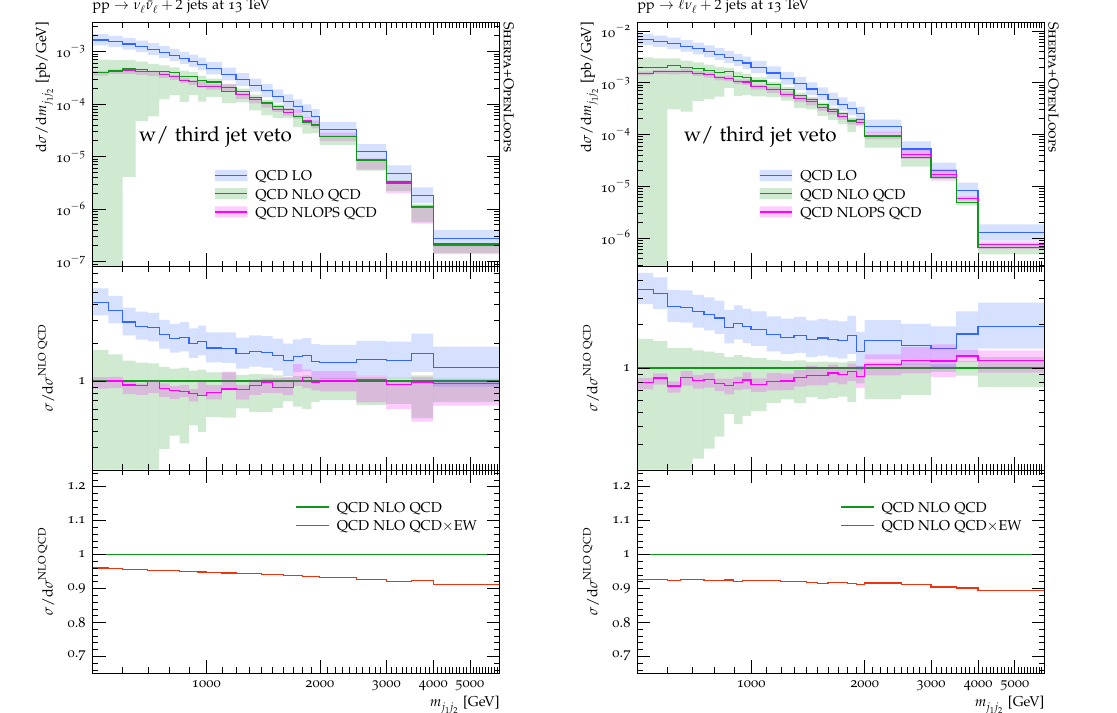
Figure 5. Distribution in the invariant mass of the two hardest jets, m j Z ( ν ‘ ¯ ν ‘ ) + 2 jets (left) and QCD pp → W ± ( ‘ ± ν ‘ ) + 2 jets (right) subject to the dynamic veto of eq. (3.12) against a third jet. Curves and bands as in figure 4 but without NLO QCD+EW